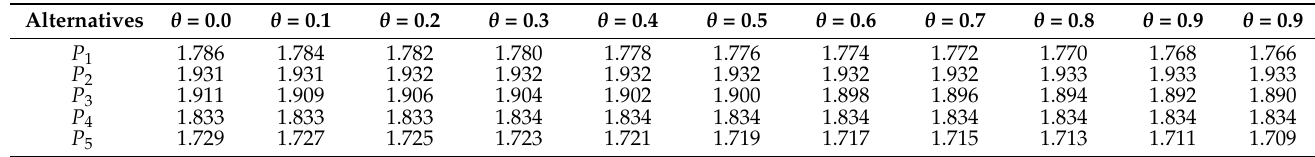
Table 9. The change of comprehensive utility value of alternatives with different θ .